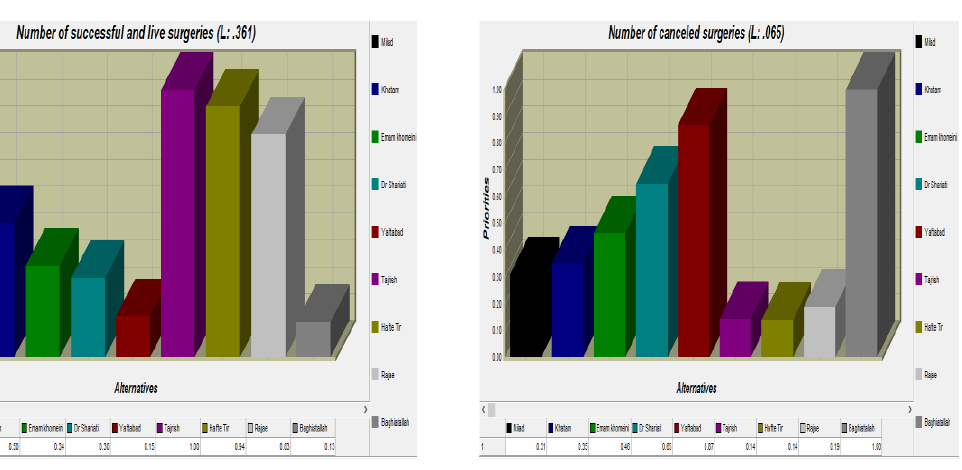
Figure 6. Ranking hospitals in terms of index C. Figure 7. Ranking hospitals in terms of index